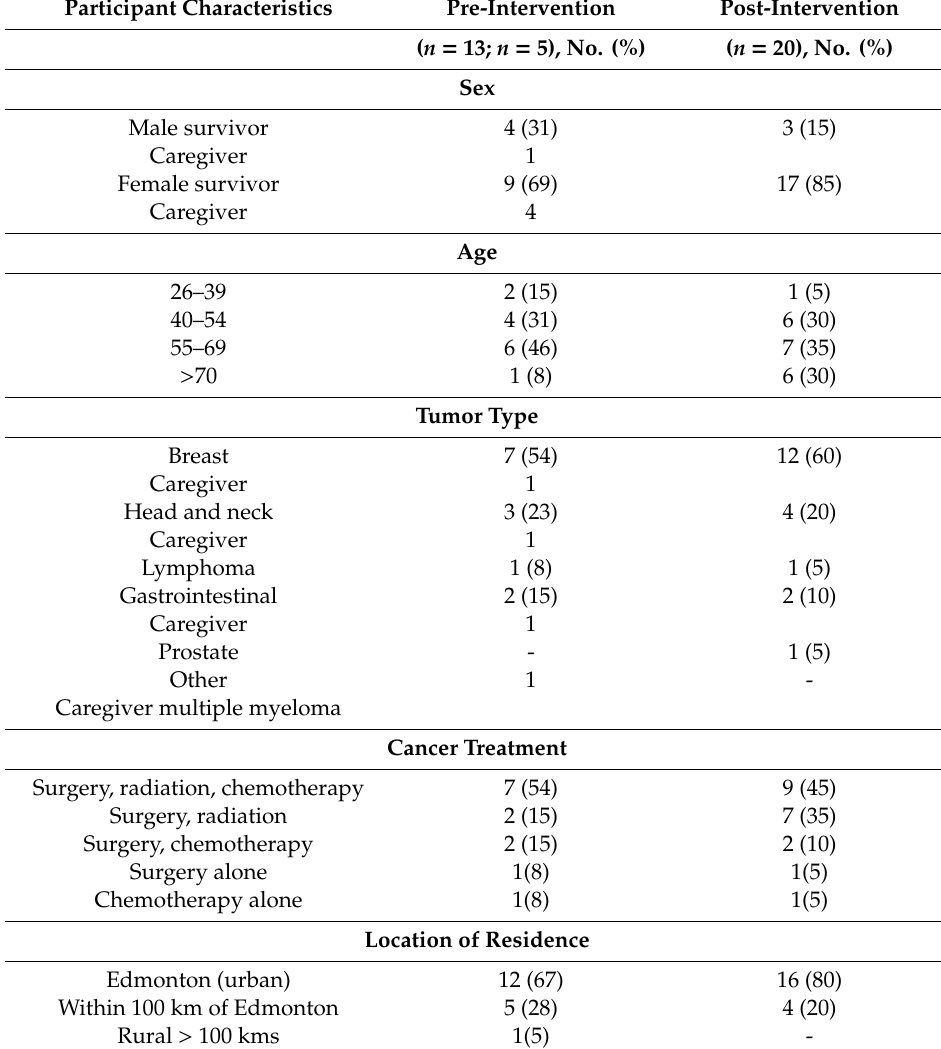
Table 1. Baseline demographic and medical